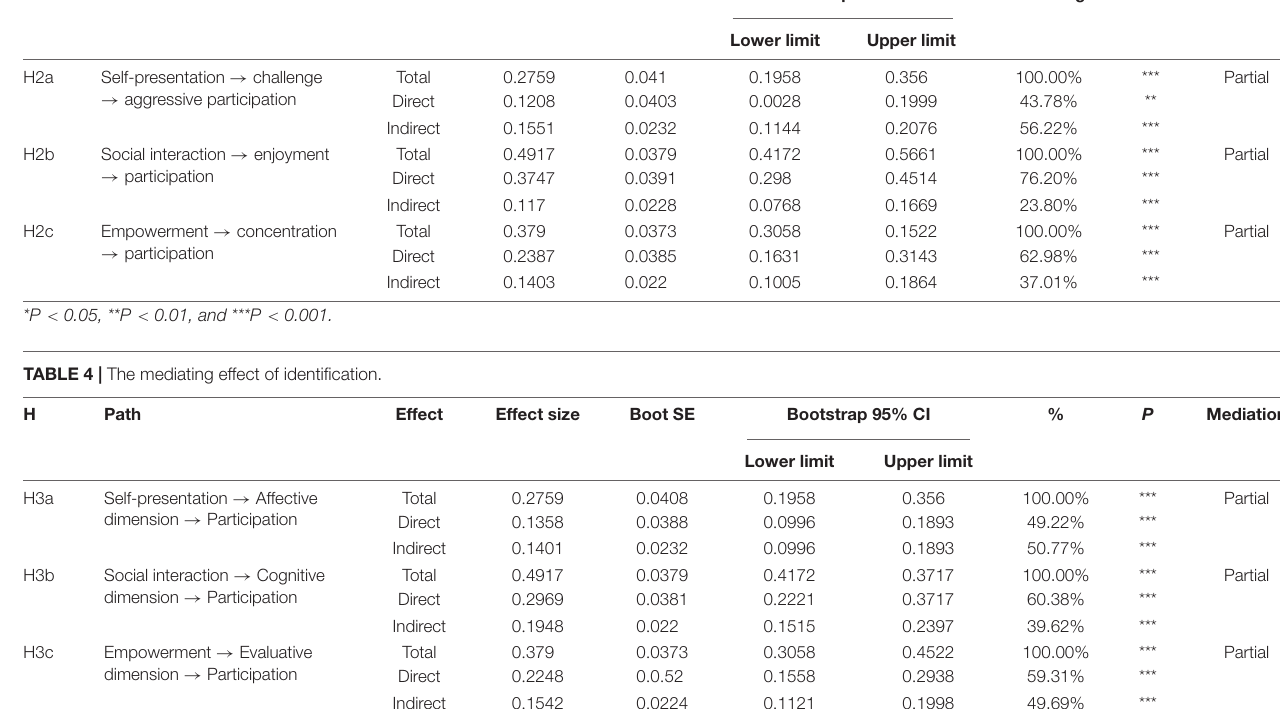
TABLE 3 | The mediating effect of flow. H